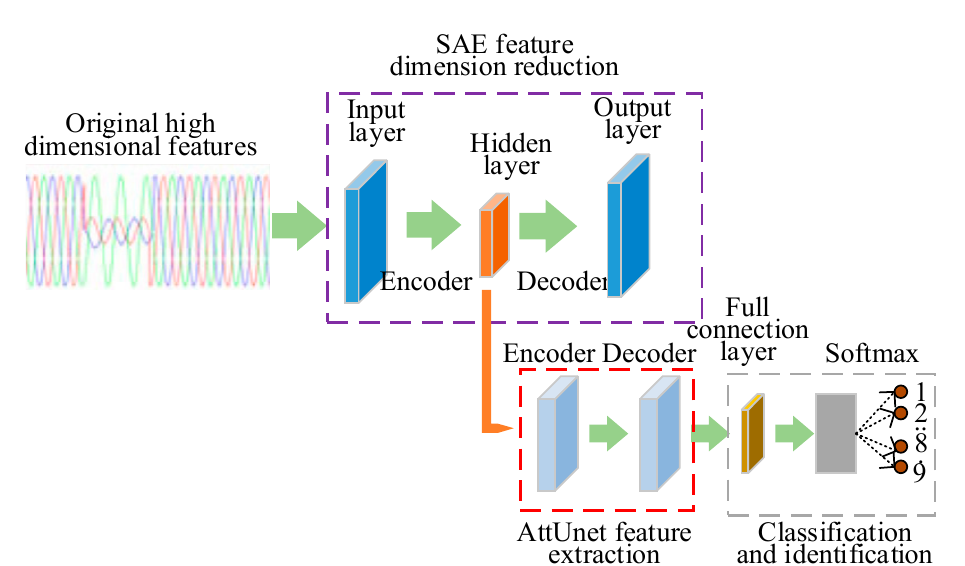
Figure 2. Structure diagram of voltage sag recognition model integrating SAE and AttUnet.